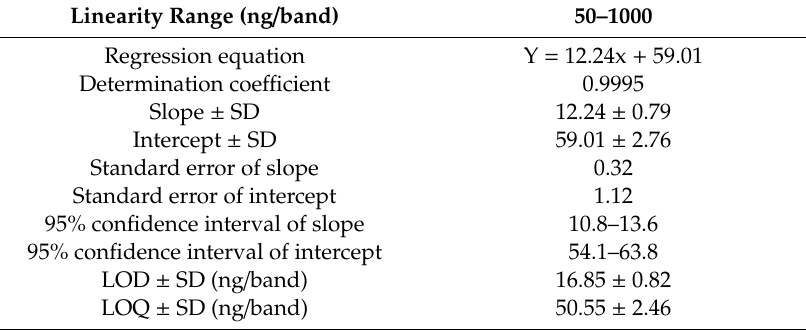
Table 1. Linear regression analysis for the calibration curve of trans-anethole (TAL) (mean ± SD; n = 6).